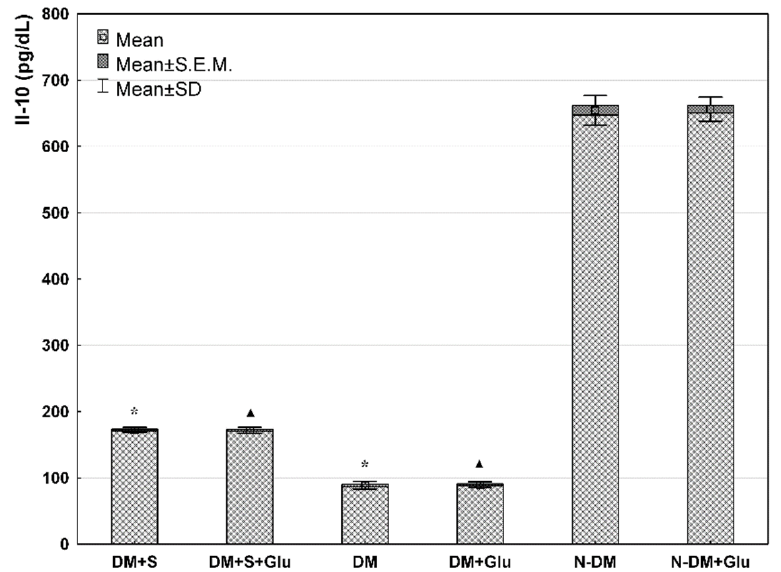
Figure 4. IL-10 level in the supernatant from a culture of human PBMCs isolated from statin-treated or statin-free type 2 diabetic patients, or from non-diabetic controls in the medium only, or preincubated with glucose (ANOVA). *—statistically significant difference compared with other groups at basic conditions, for p ≤ 0.05 ; ▲ —statistically significant difference compared with other groups in the presence of glucose, for p ≤ 0.05.